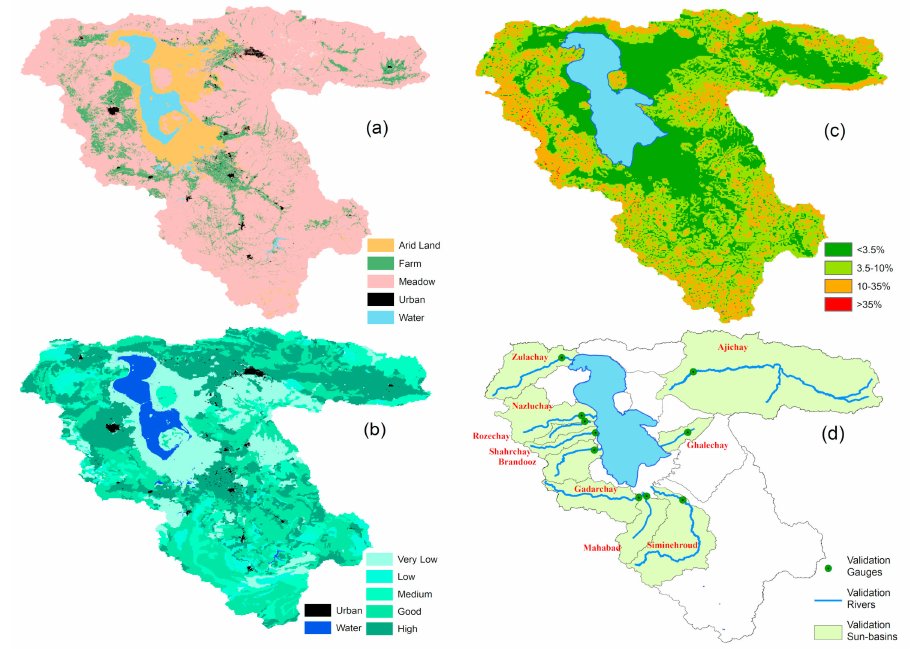
Figure 2. Lake Urmia basin data: ( a ) land use, ( b ) permeability, ( c ) slope, and ( d ) validation